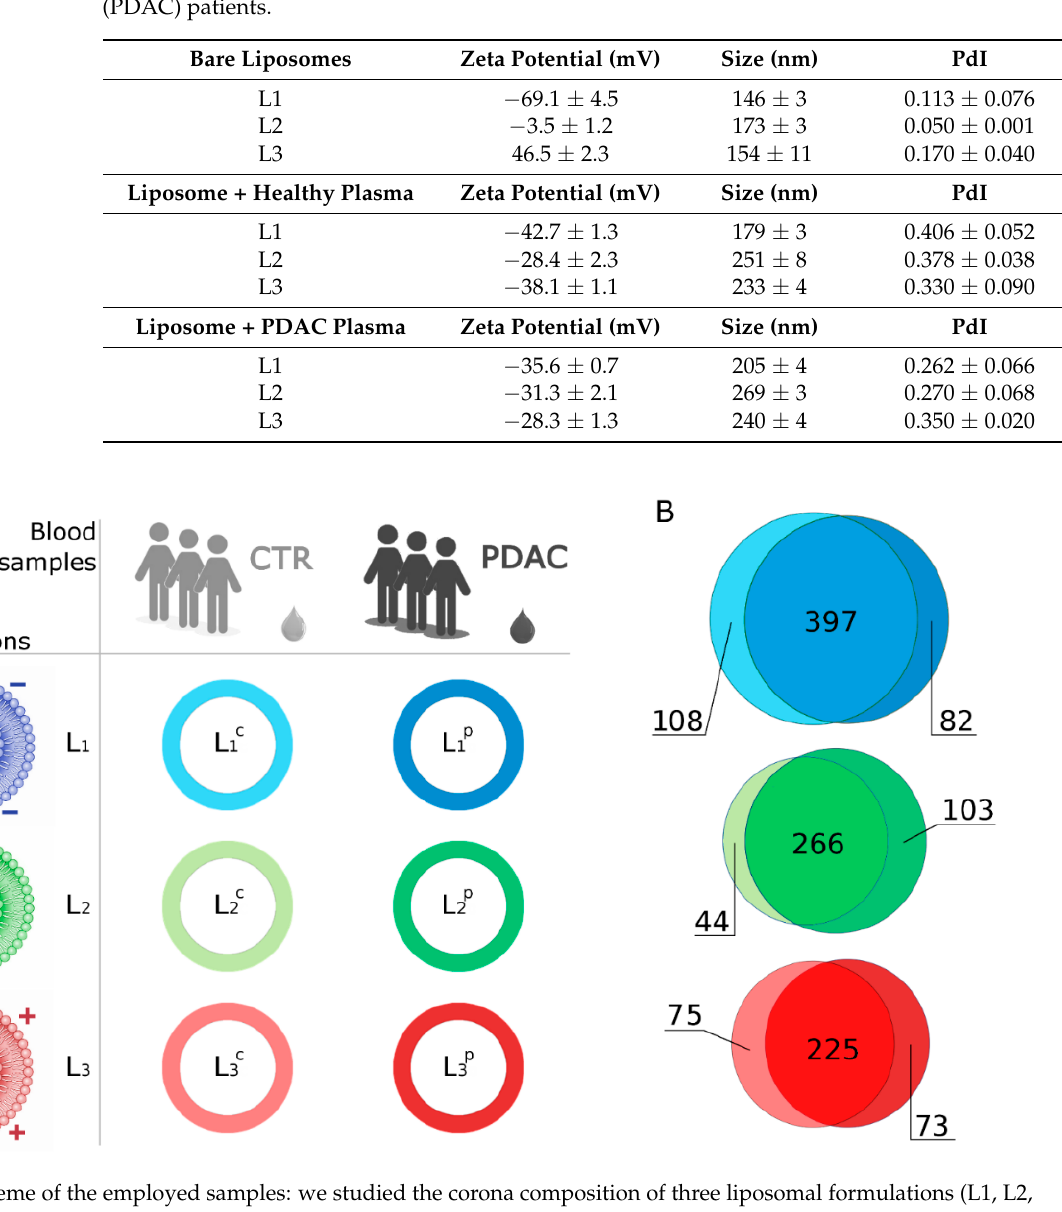
Figure 1. ( A ) Scheme of the employed samples: we studied the corona composition of three liposomal formulations (L1, L2, and L3) with different surface charge (anionic, neutral and cationic, respectively), upon incubation with human plasma from non-oncological (CTR) and pancreatic cancer (PDAC) patients. ( B ) Venn diagrams depicting the number of detected proteins in CTR and PDAC coronas for each liposomal formulation.